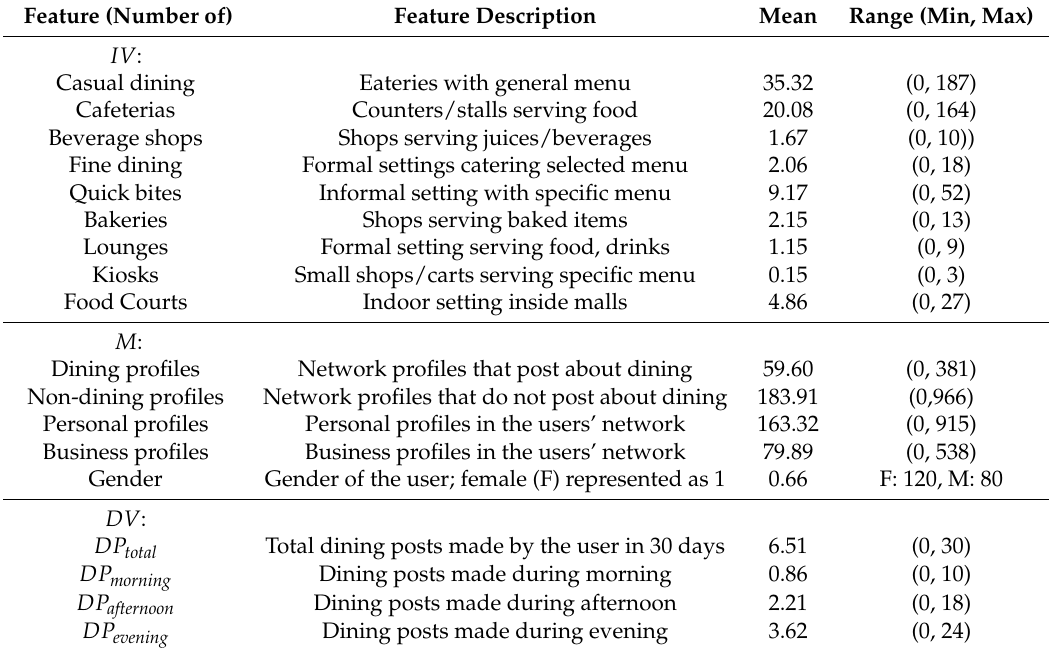
Table 1. Summary of variables tested: independent variables ( IV ), mediator variable ( M ) and dependent variable ( DV